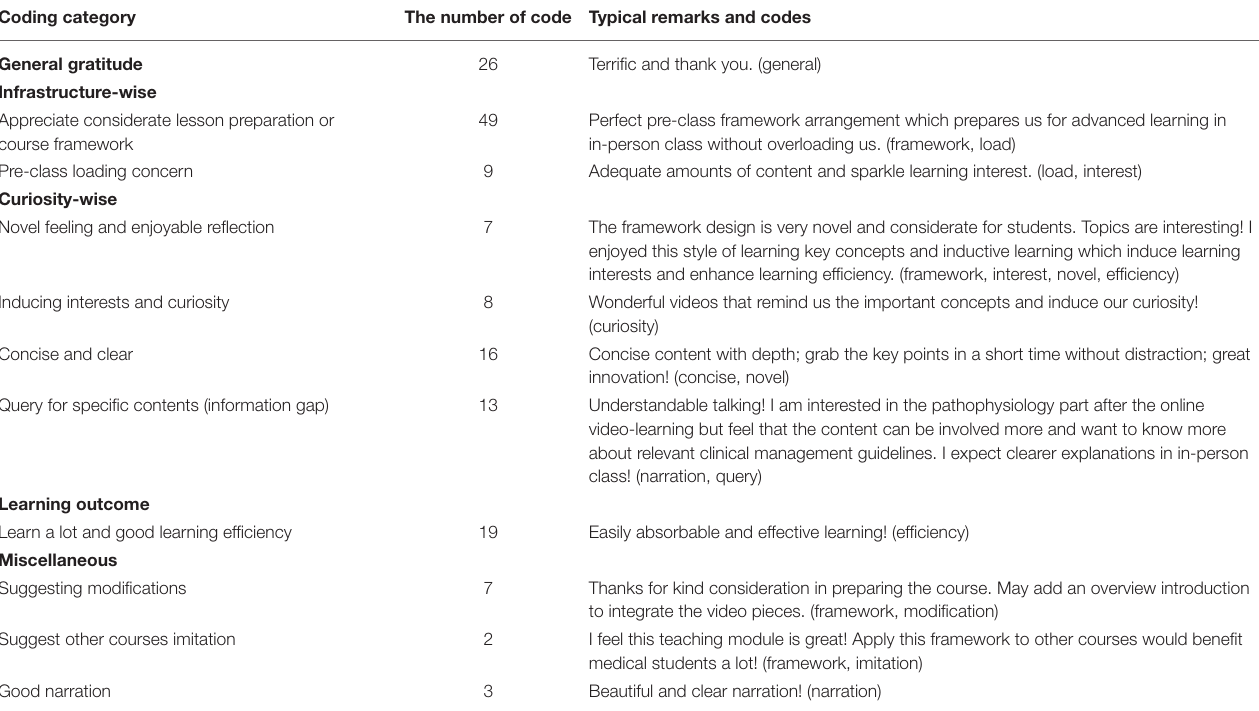
TABLE 4 | Students’